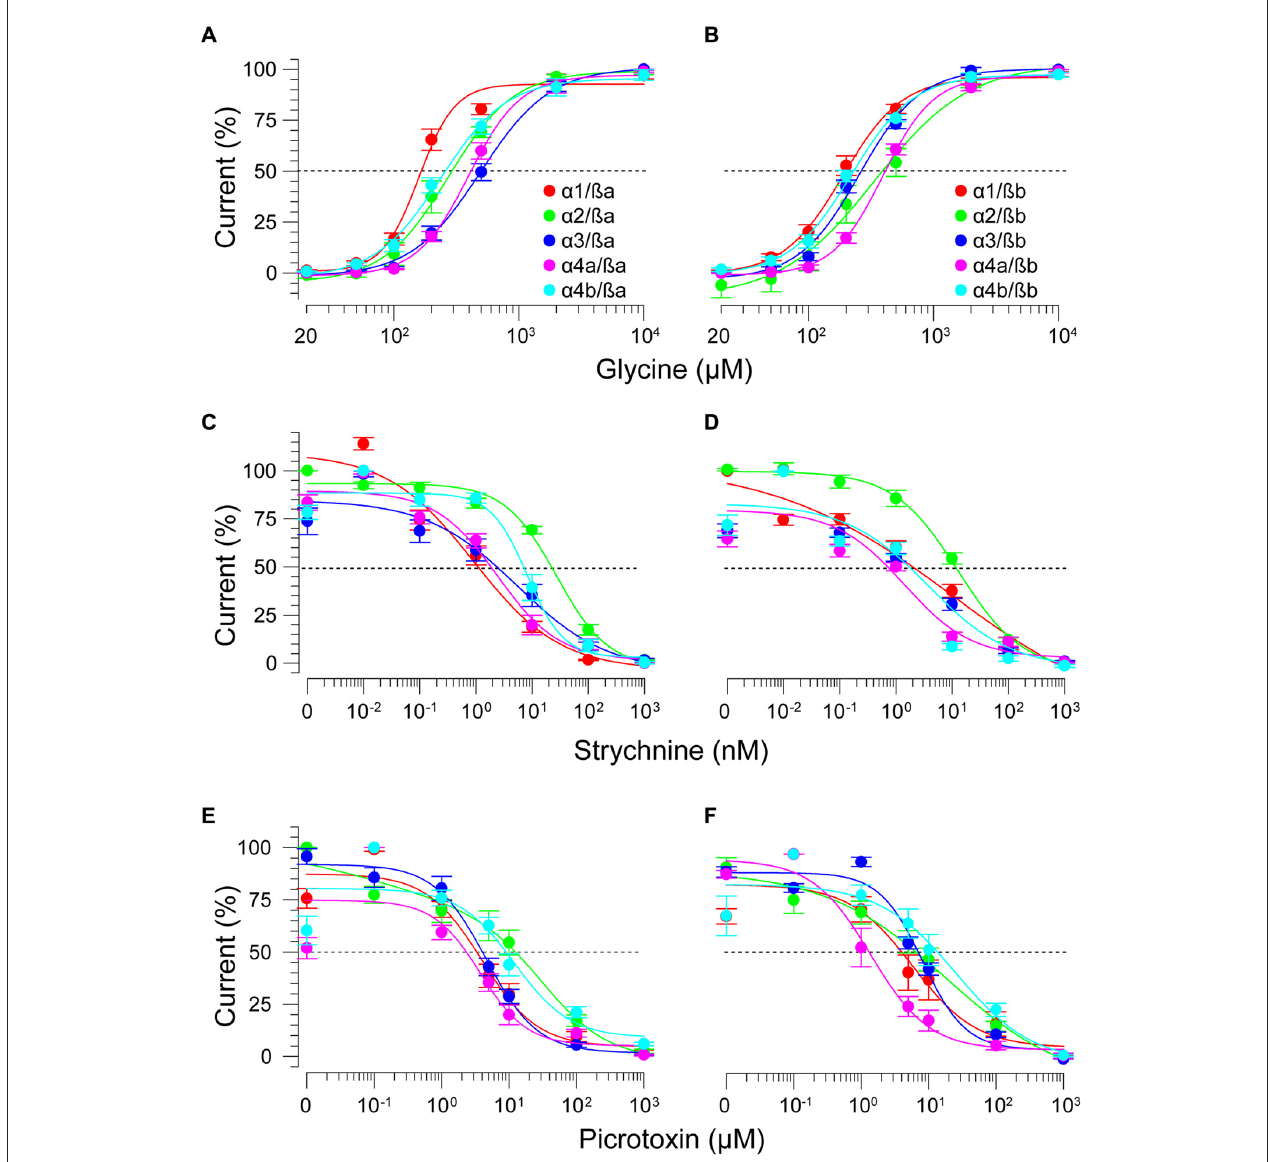
FIGURE 5 | zGlyRß subunits form functional heteromeric receptors with zGlyR α subunits. Cumulative dose-response relationships of glycine-evoked currents from oocytes co-injected with 2.5 femtomoles of zGlyR α cRNA and 2.5 femtomoles of either zGlyRßa (A) or zGlyRßb (B) cRNA. Ten oocytes were used for each